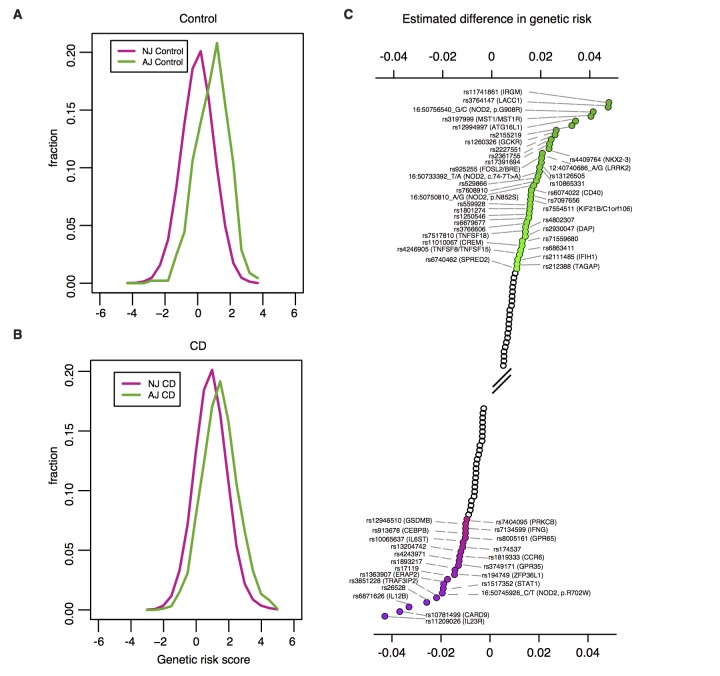
AJ individuals have higher CD polygenic risk score than NJ controls.NJ: non-Jewish; AJ: Ashkenazi Jewish; CD: Crohn’s disease; PRS: polygenic risk score. A) Density plot of CD polygenic risk scores in 454 AJ (green) and 35,007 NJ(purple)controls. AJ controls have higher CD polygenic risk score than NJ controls (0.97 s.d. higher, p<10−16). B) Density plot of CD polygenic risk scores in 1,938 AJ (green) and 20,652 NJ CD (purple) cases (0.54 s.d. higher, p<10−16). For both density plots the scores have been scaled to NJ controls, thus resulting in an NJ control PRS density of mean equal to 0 and variance equal to 1 (see Online Methods). C) Ranked (decreasing order) CD associated variants by estimated contribution to the differences in genetic risk between AJ and NJ. Associated variants with estimated contribution greater than or equal to 0.01, computed as 2 log(odds ratio) (AJ frequency—NJ frequency), assuming additive effects on the log scale, are highlighted in green. Associated variants with estimated contribution less than or equal to -0.01 are highlighted in purple. Forward slashes represent a break in variants highlighted.